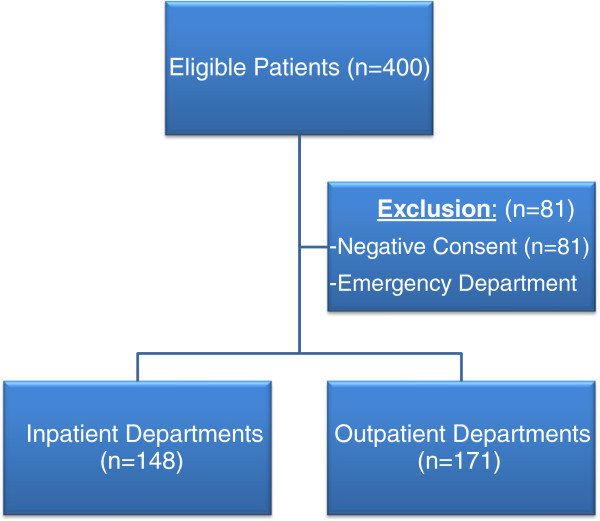
Recruitment summary.